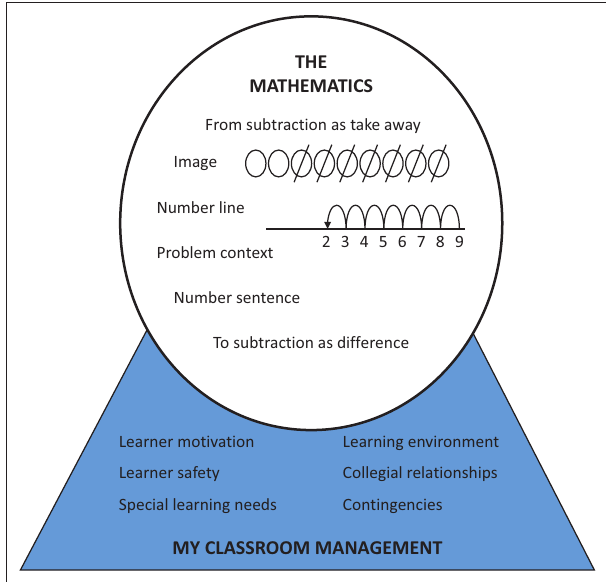
FIGURE 8: Relating the mathematics to the classroom